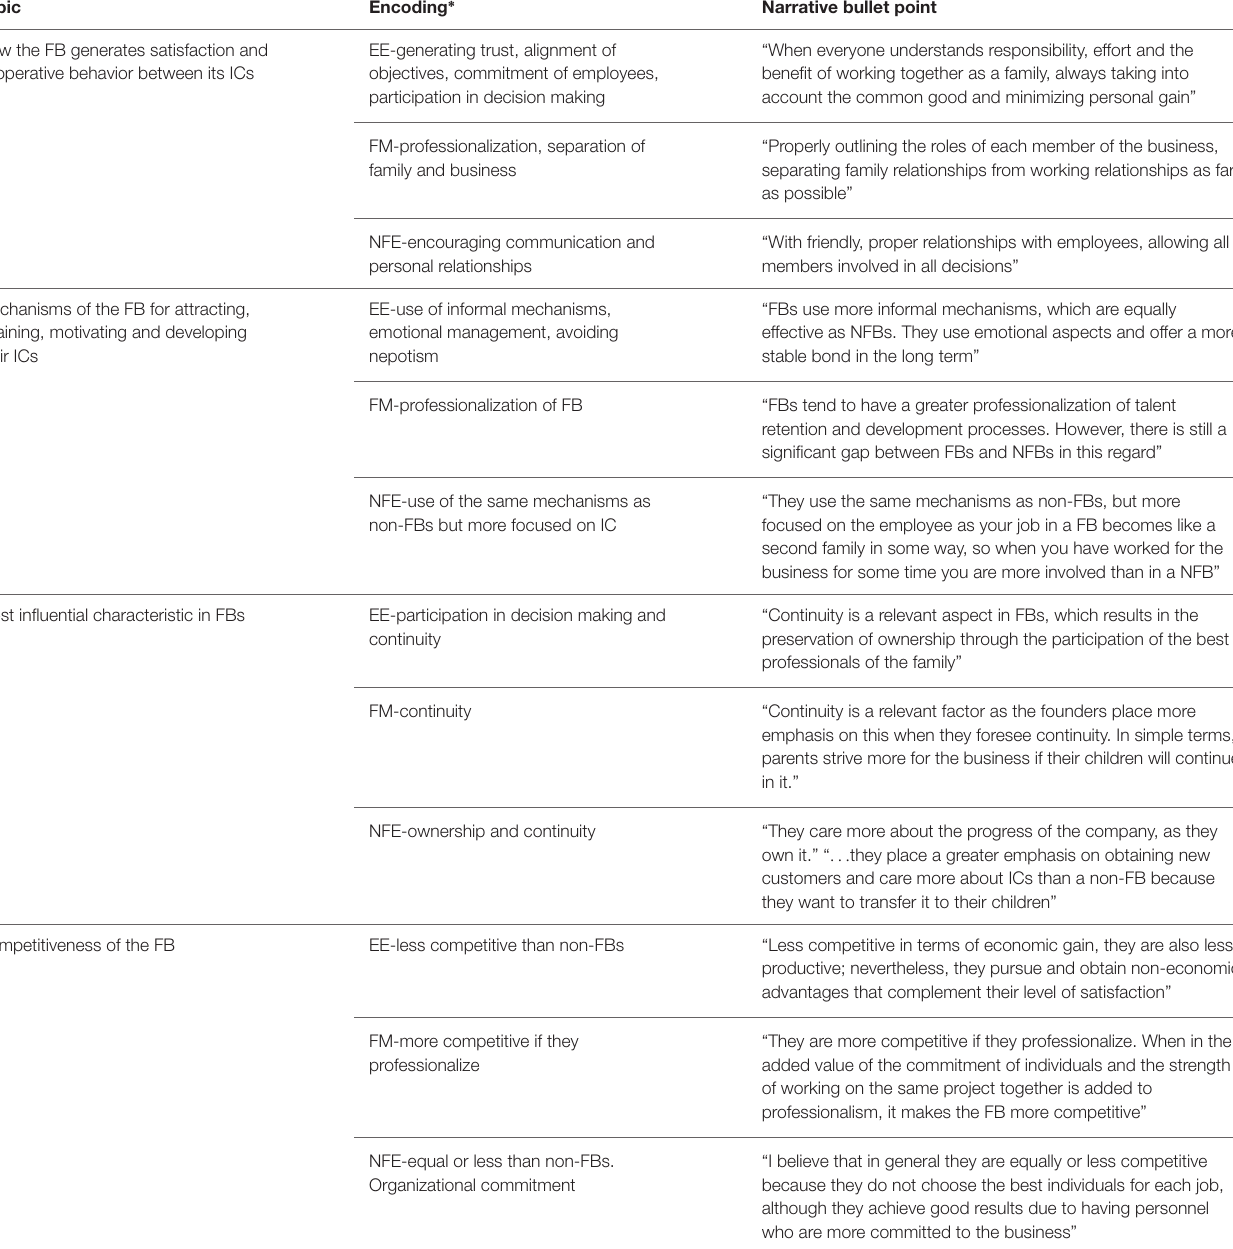
TABLE 3 | Information from the qualitative analysis. Topic Encoding ∗ Narrative bullet